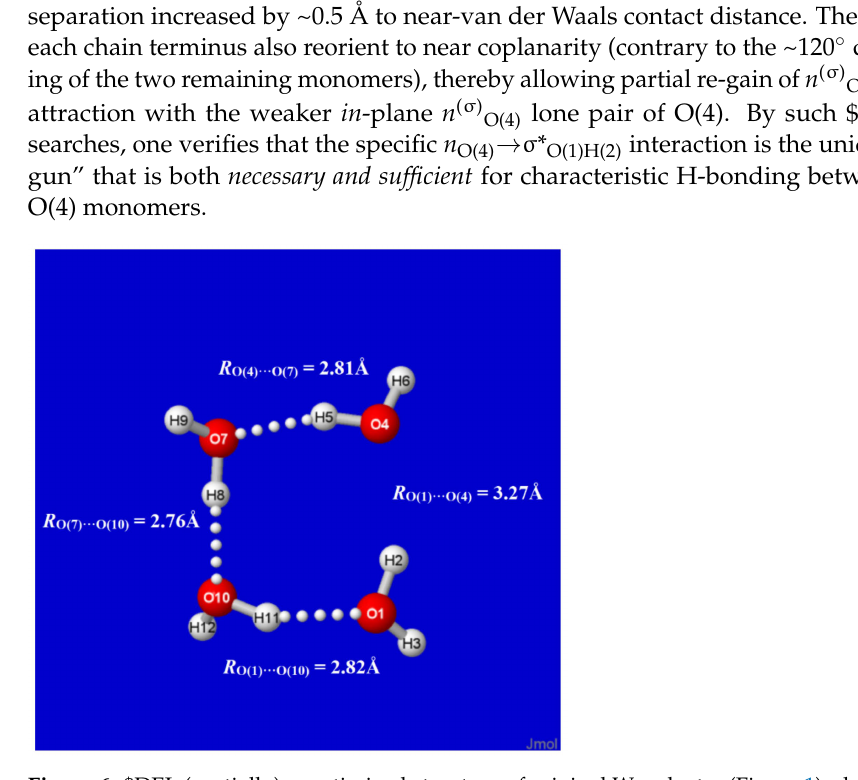
Figure 6. $DEL (partially)-reoptimized structure of original W 4c cluster (Figure 1), showing effects of deleting the single n O(4) → σ * O(1)H(2) interaction of Figure 5 (at the point where the maximum number of optimization steps was